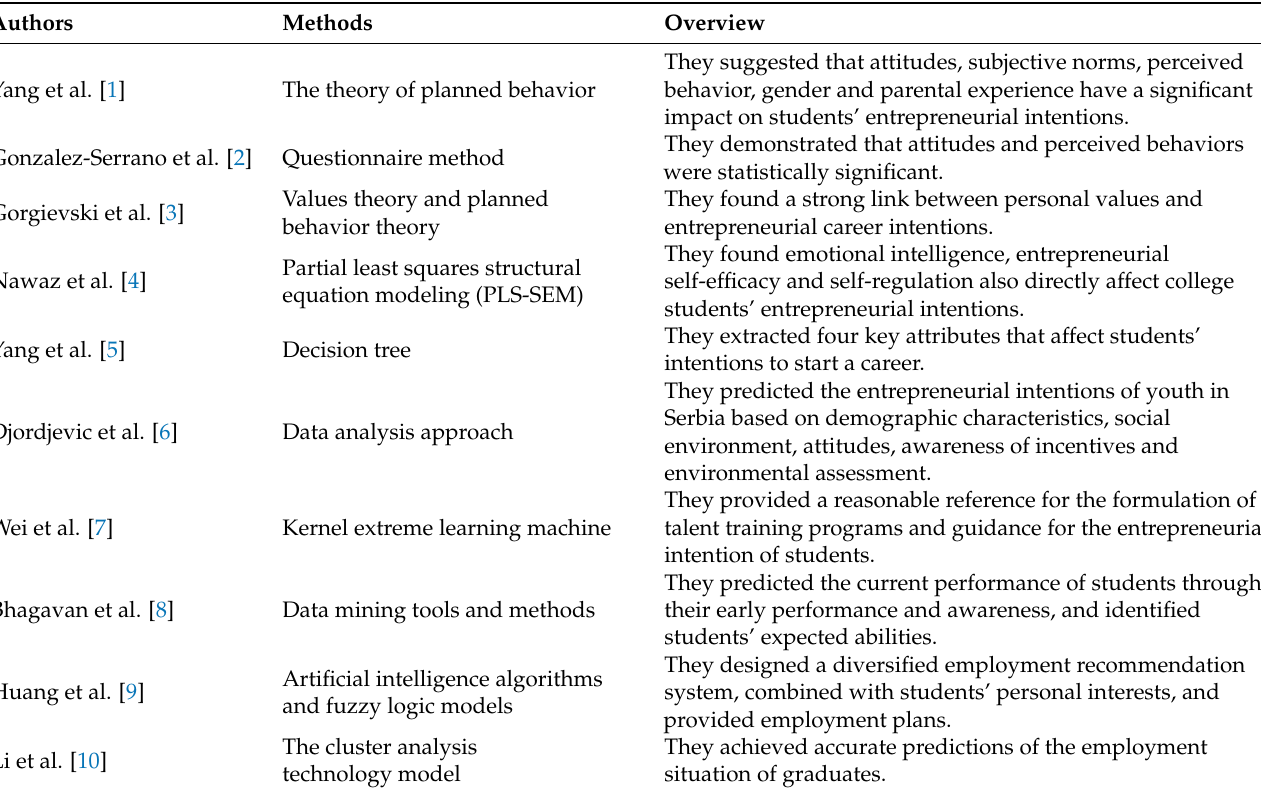
Table 1. The latest research status of prediction issues for